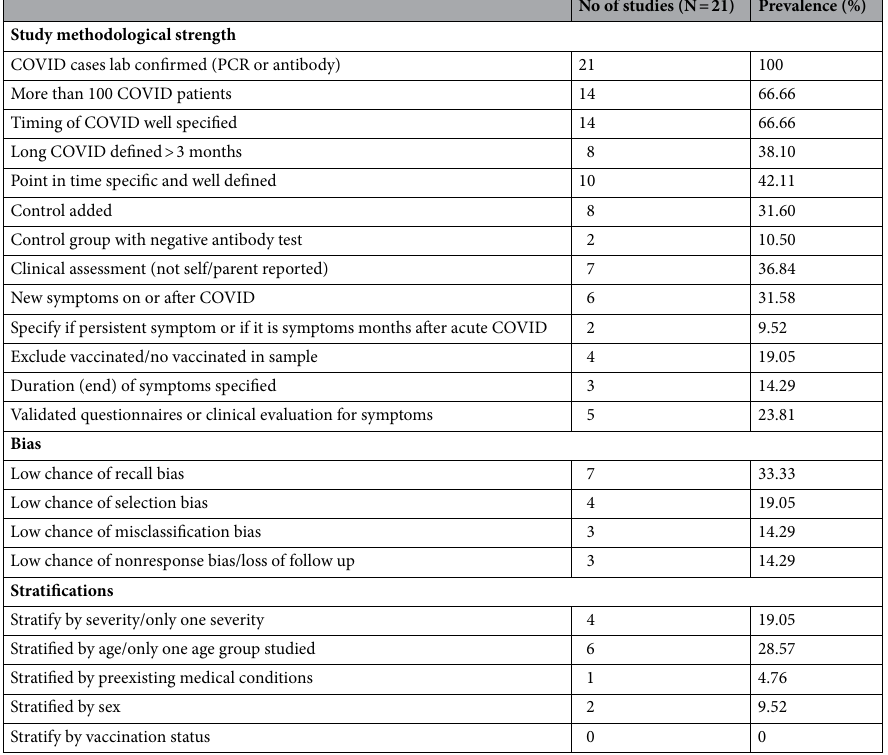
Table 3. Study methodological strengths and